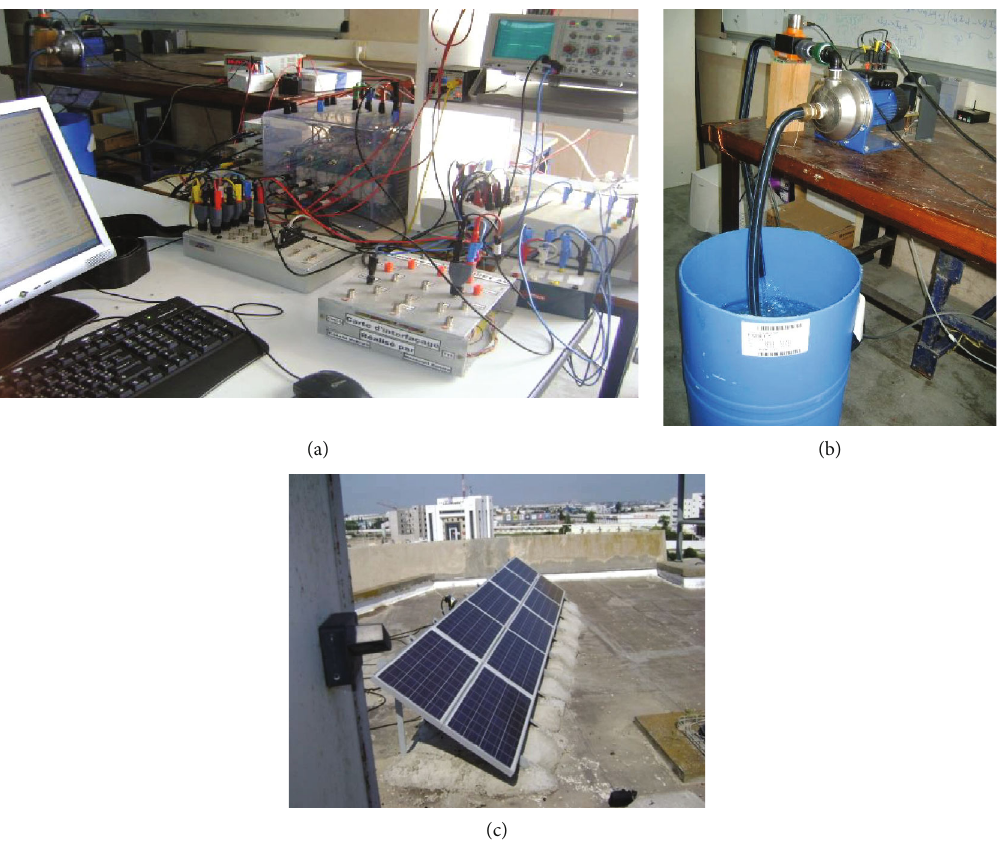
Figure 12: The hardware setup of the SPVWPS: (a) overview of the test bench; (b) motor pump with fl ow meter and water tank; (c) a series connection of 10 panels.